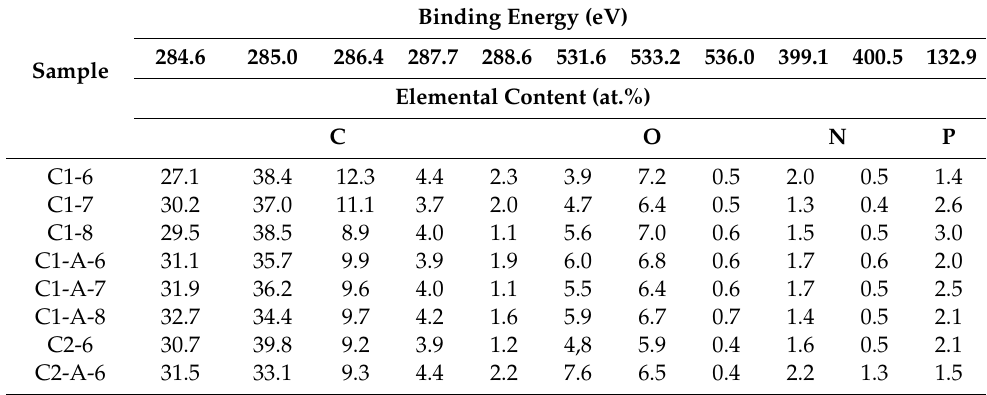
Table 3. Chemical composition analyzed by X-ray photoelectron spectroscopy (XPS) for C1-T, C1-A-T, C2-T, and C2-A-T